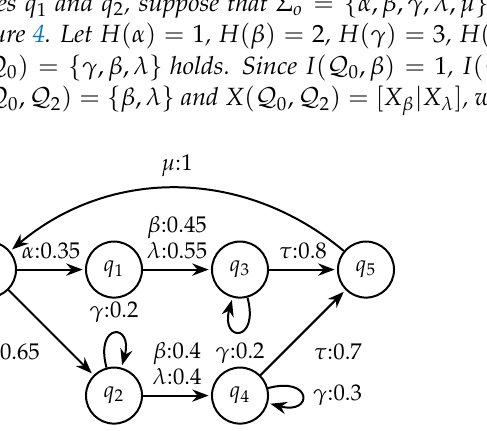
Figure 3. A probabilistic automaton structure G (cid:48) s .